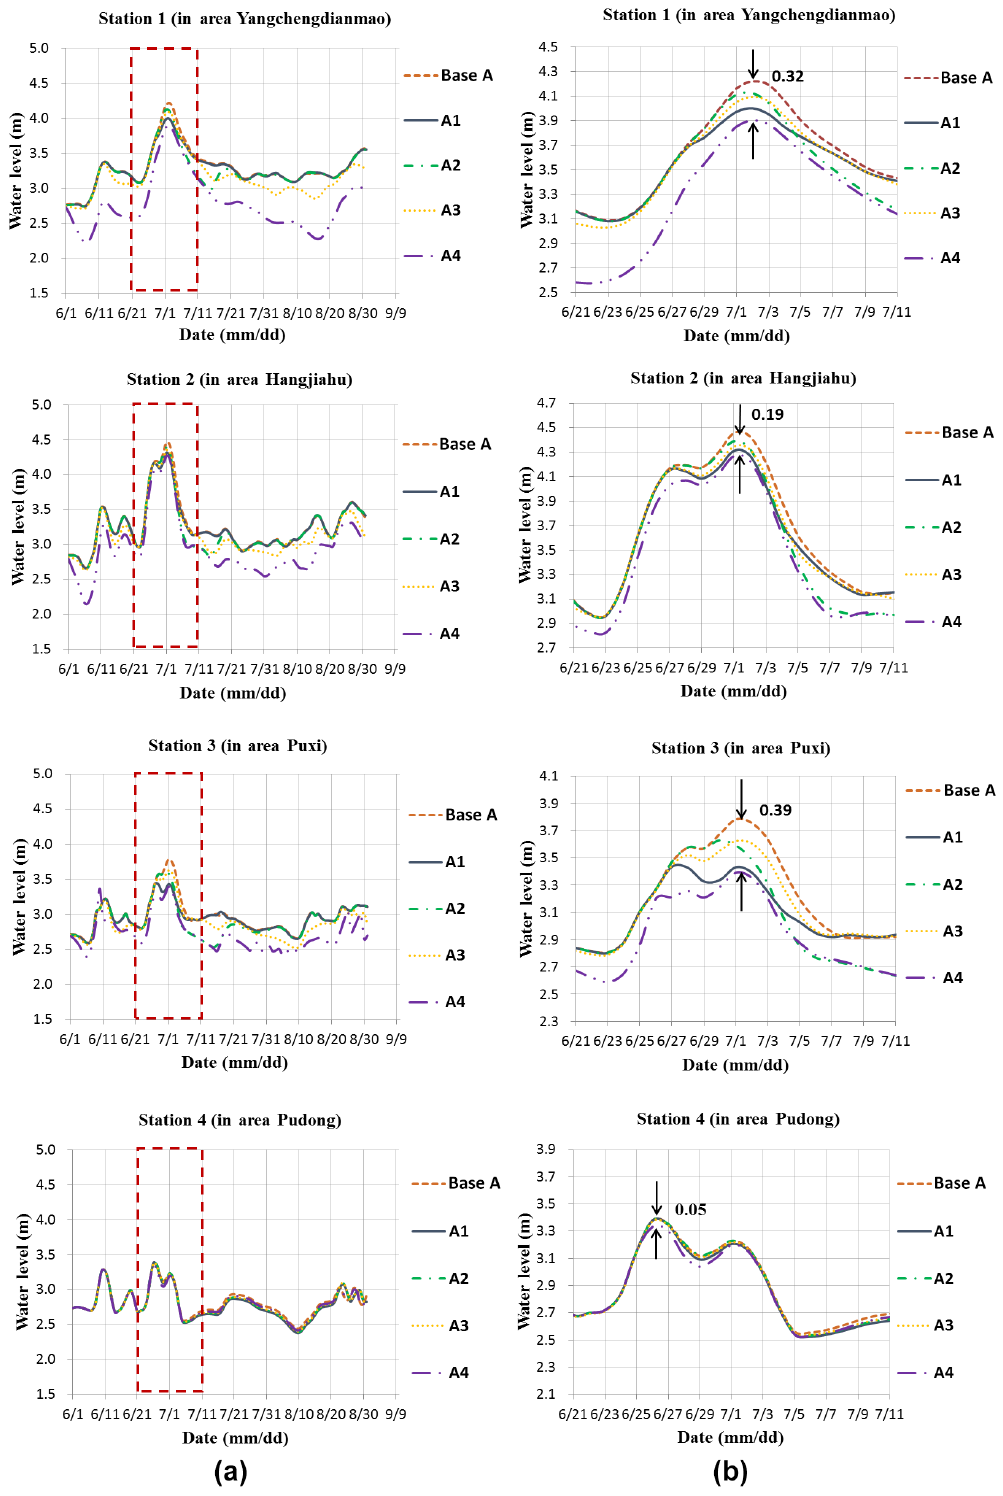
Figure 9. Comparison of the simulated daily water levels during the period from June to August in 1999 at four stations (as shown in Fig. 1) under the five scenarios considered in this study (the figures on the right-hand side – b – are the zoom-in plots of the figures on the left-hand side – a